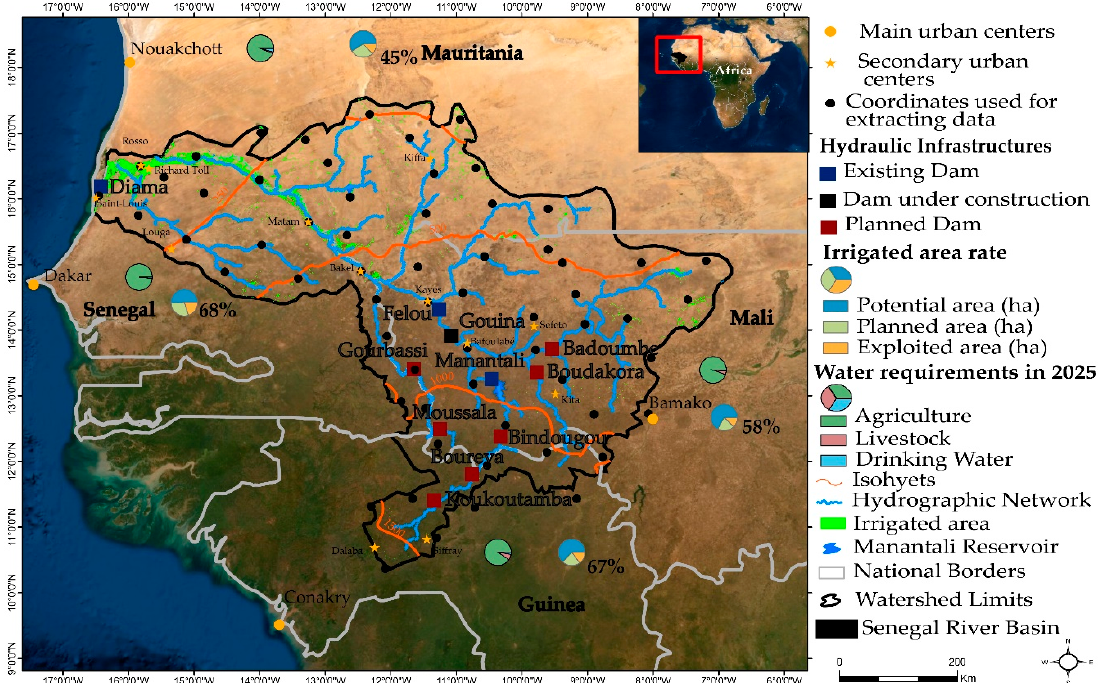
Figure 1. Senegal River Basin, stations used for the extraction of climatic variables, hydraulic infrastructures, water uses, and needs by sector of activity.